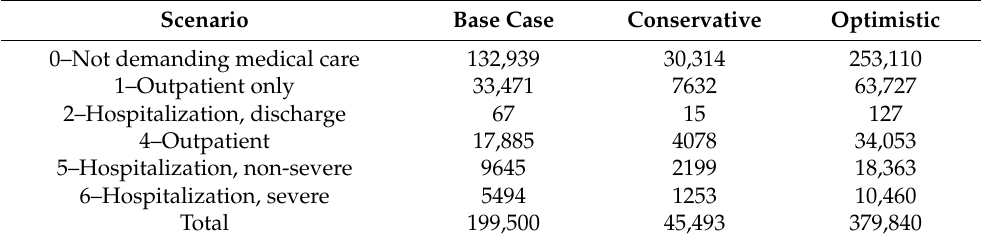
Table 10. Estimated influenza cases averted by immunizing the target population 1 : Sensitivity analysis.